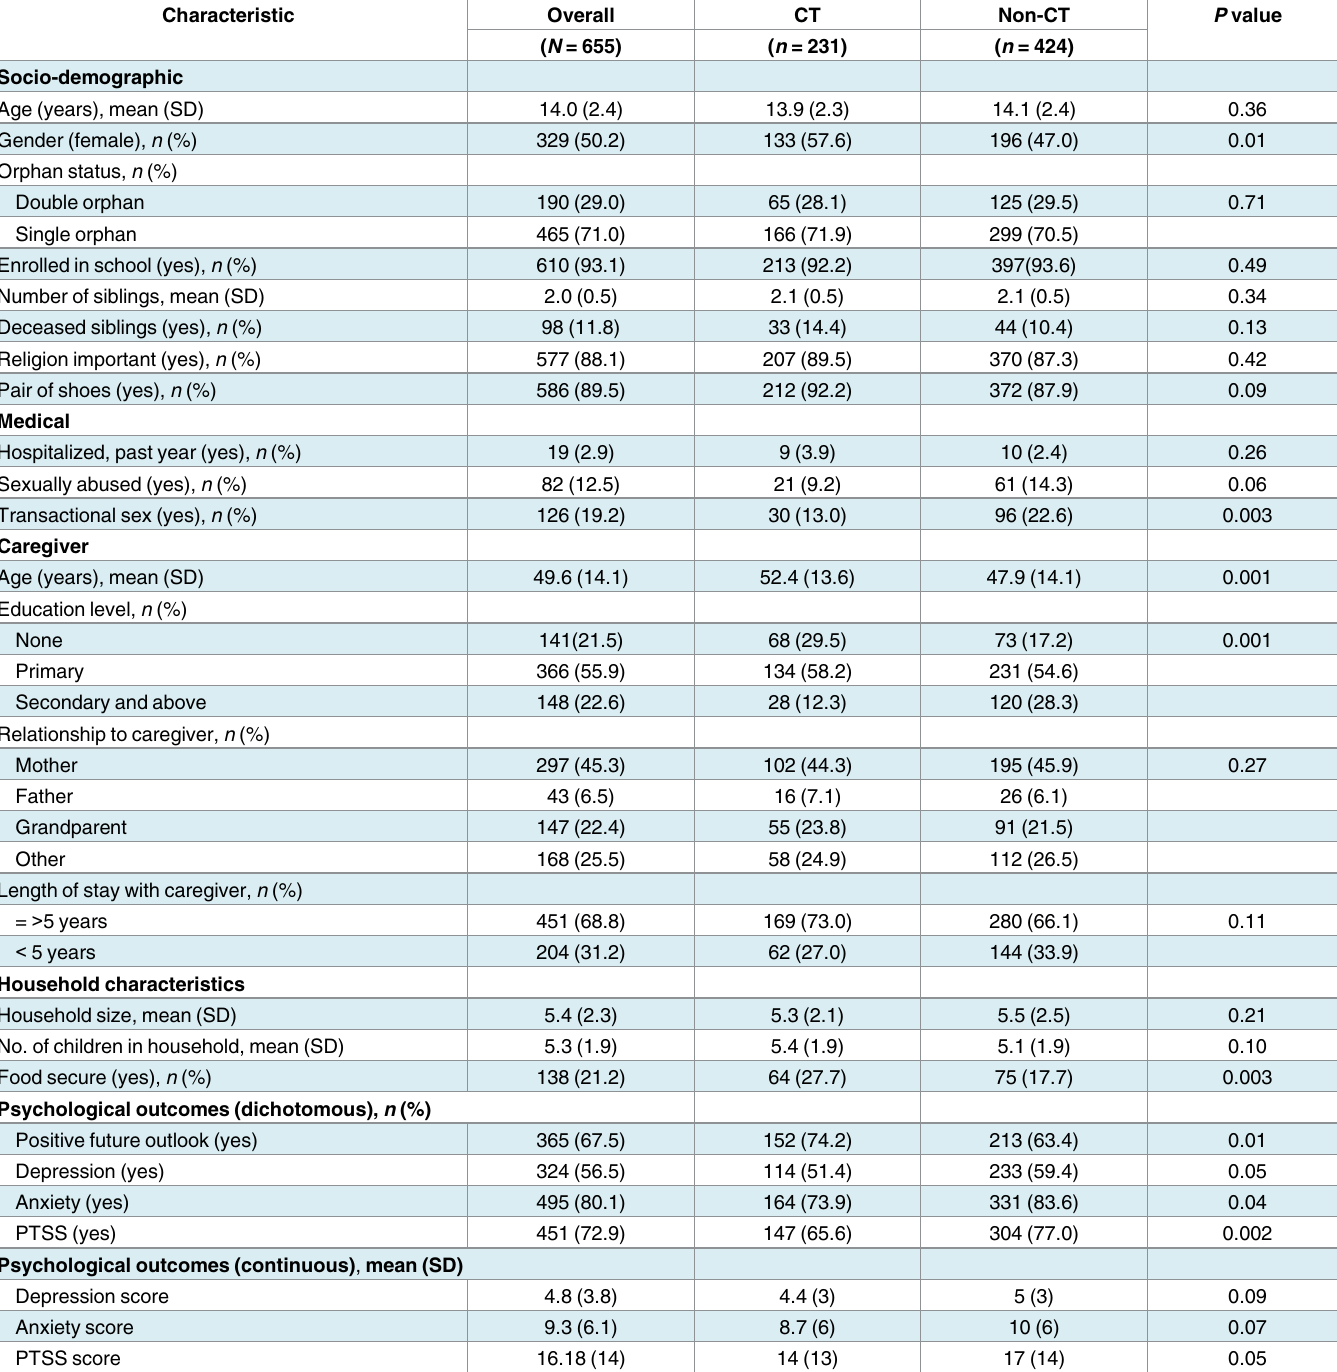
Table 1. Demographic, caregiver, household, and psychological characteristics of OVA aged 10–18 by CT status.